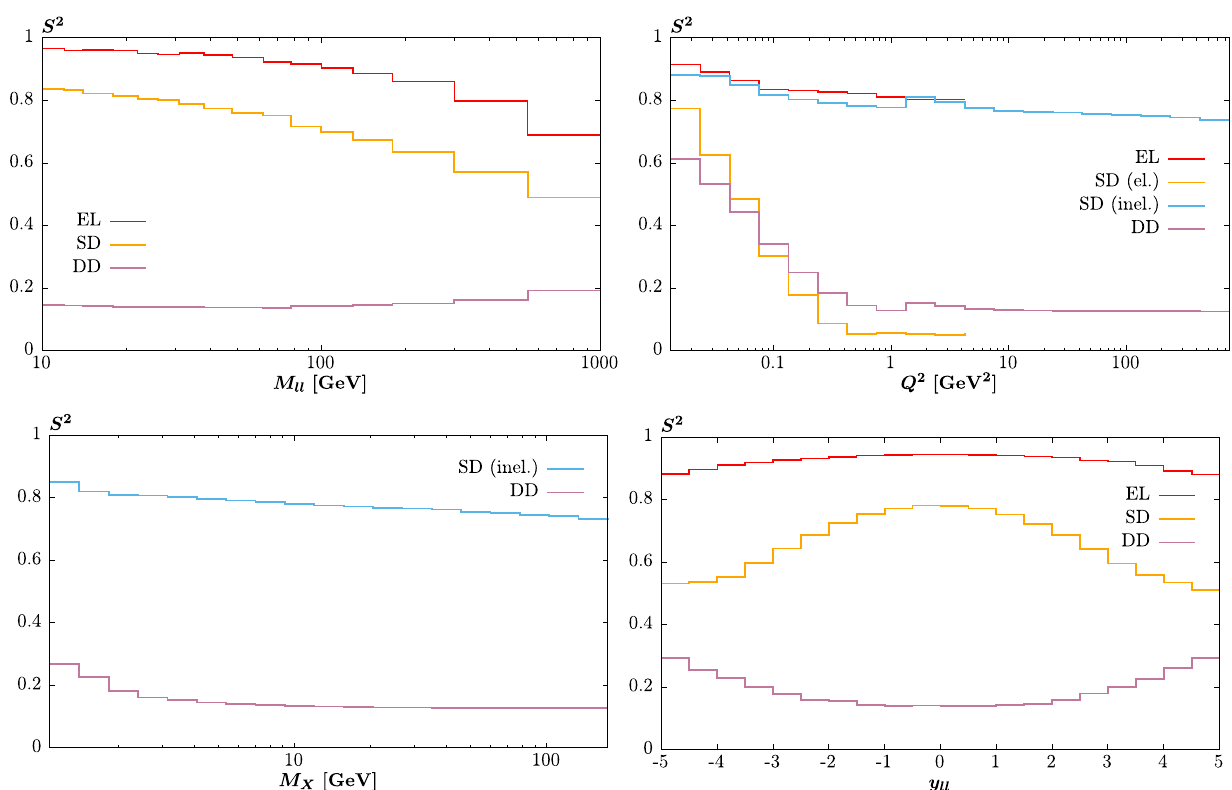
Fig. 1 Soft survival factor for lepton pair production as a function of though the results are largely insensitive to this precise choice of cuts, and lepton mass effects are negligible in this region. For the invariant the invariant mass, M ll , of the dilepton system, the photon Q 2 , the mass distribution we impose a lower cut of p l ⊥ > 1 GeV in order to invariant mass of the dissociation system, M X , and the dilepton rapid- ity, y ll . Results are given for elastic, SD (with the elastic or inelastic reduce kinematic effects at low masses. For the elastic and SD (elastic) Q 2 distributions, the plots are cutoff when the effect of limited vertex indicated where relevant) and DD, and correspond to muon pair √ s = 13 TeV and lepton p l ⊥ > 10 GeV, | η l | < 2 . 5, production with